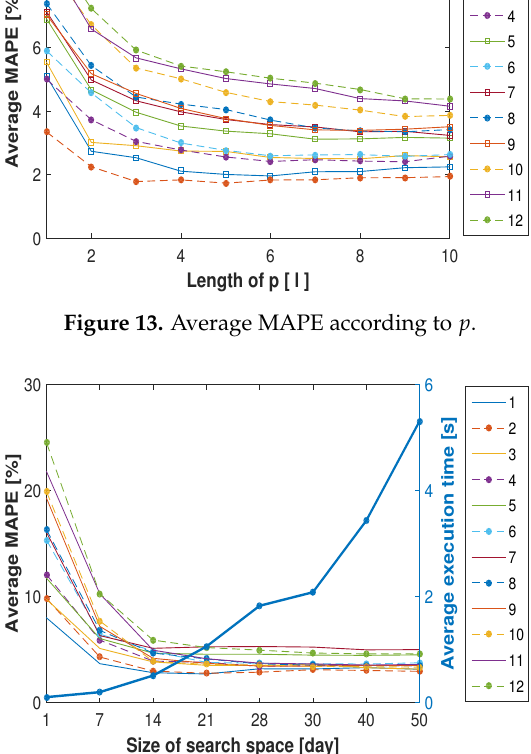
Figure 14. Average MAPE according to t max